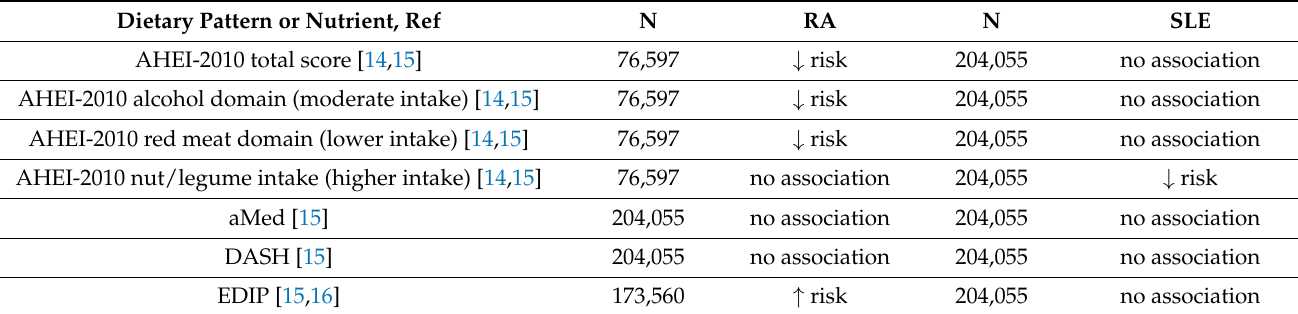
Table 1. Comparison of data available about different dietary patterns and the risk of developing rheumatoid arthritis (RA) and systemic lupus erythematosus (SLE) in normal